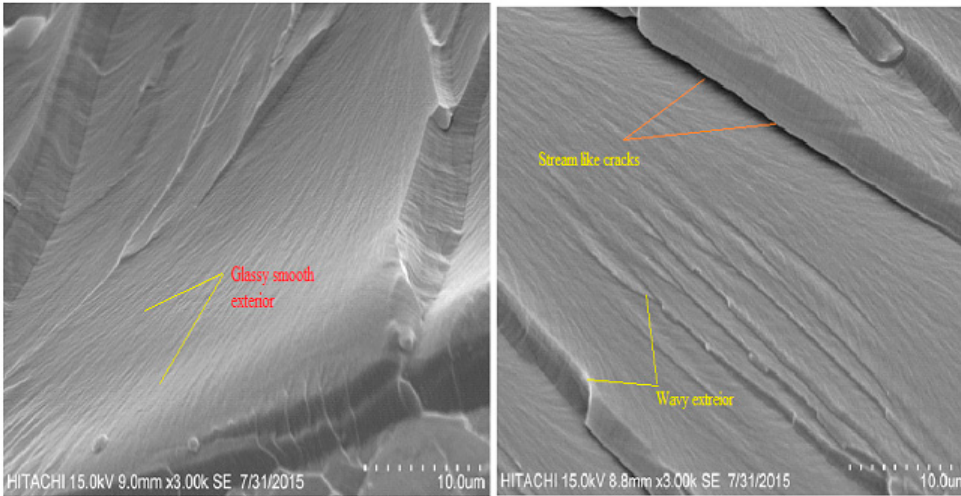
Figure 10. SEM images of pure epoxy composites.